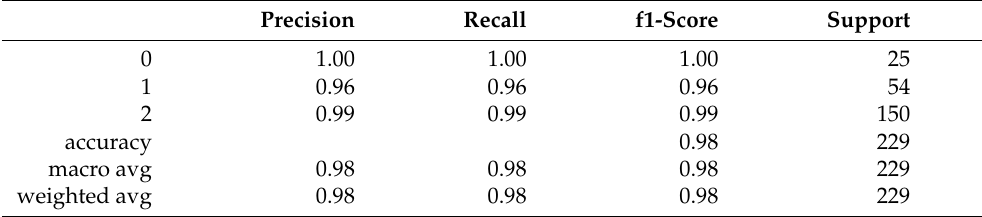
Table 12. Gradient boosting tree metrics on test-set. Precision Recall